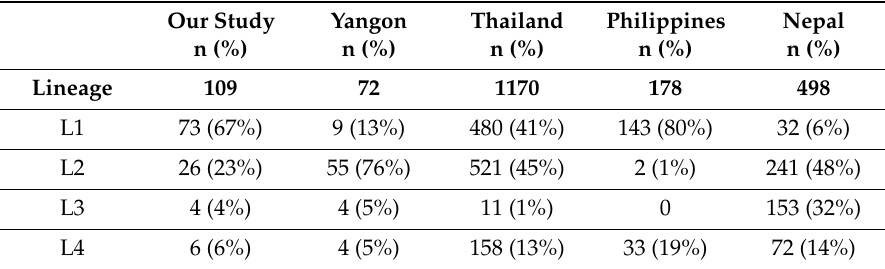
Table 7. Distribution of MTB lineages in our study compared to other